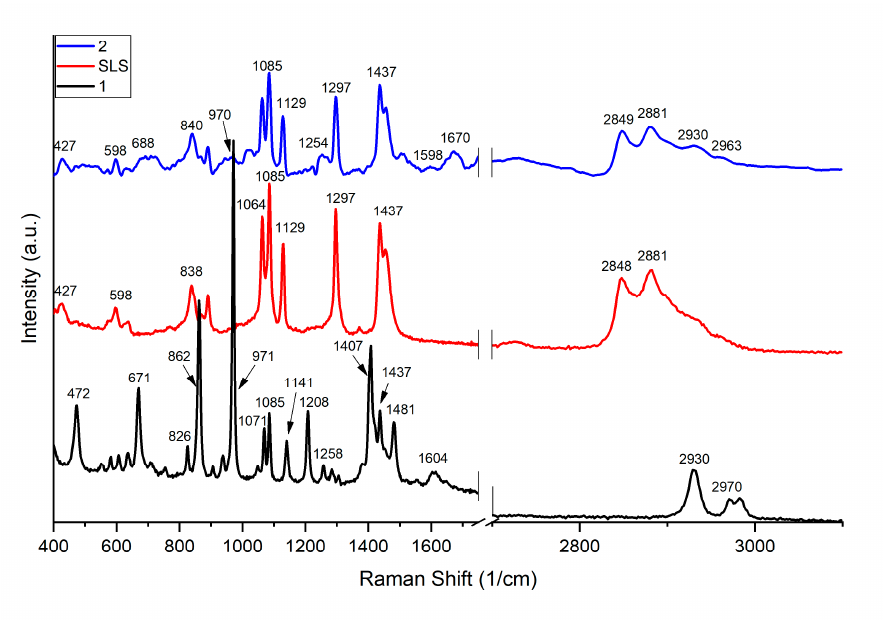
Figure 3. Raman spectrum of the micelle of 2 compared to corresponding ones for sodium lauryl sulphate (SLS) and 1. The spectra are artificially offset for clarity. The data for 2 was baseline corrected due to fluorescence.